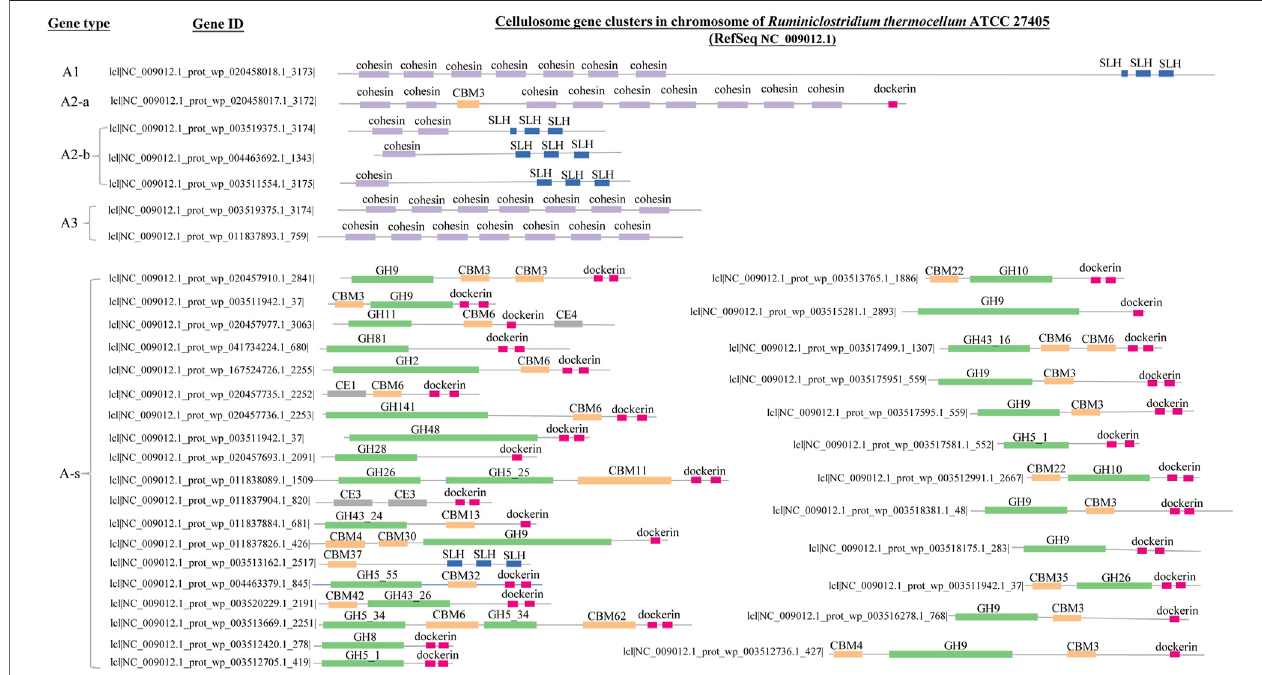
FIGURE5| Genesofcellulosomegeneclustersinthechromosome(NC_009012.1)of Ruminiclostridiumthermocellum ATCC27405.TheGHmodules,theCBMmodules, theSLHmodule,thedockerinmoduleandthecohesionmodulearerepresentedwithbarsingreen,yellow,blue,pinkandpurple,respectively;thewidthofeachbaranditsposition denotelength(bp)ofeachmoduleanditspositionalonggenes.De fi nitionofthedifferentgenetypes (A1,A2-a,A2-b,A3,A-s) arethesameasthatsummarizedin Table1 and Figure 2 . The corresponding IDs of all the cellulosome genes have also been